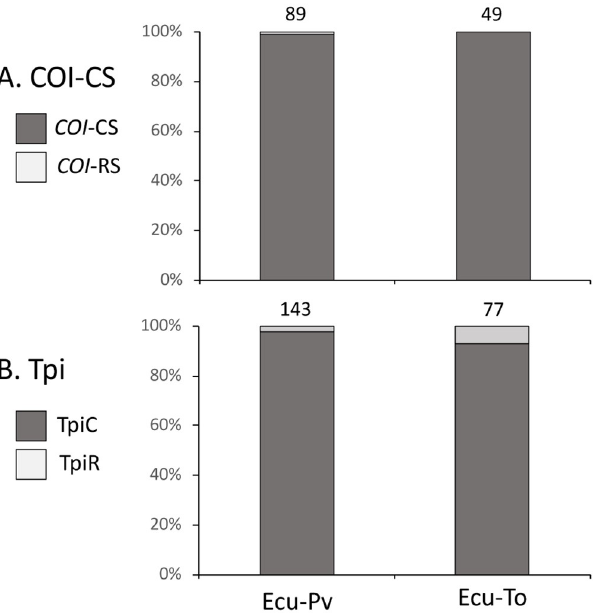
Fig 3. Comparisons of COI and Tpi haplotype frequencies of fall armyworm in Ecuador. A. Frequency of the COI strain diagnostic markers based on analysis of the COIB segment. Number of specimens indicated above columns. B. Frequency of the Tpi strain diagnostic markers from the TpiE4 exon segment. Estimated number of chromosomes tested indicated above columns.